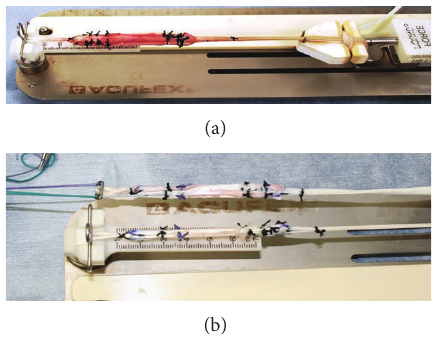
Figure 2: Our PCL substitutes made from the semitendinosus and gracilis tendons. (a) Substitute for single-bundle PCL reconstruc- tion. (b) Substitute for double-bundle PCL